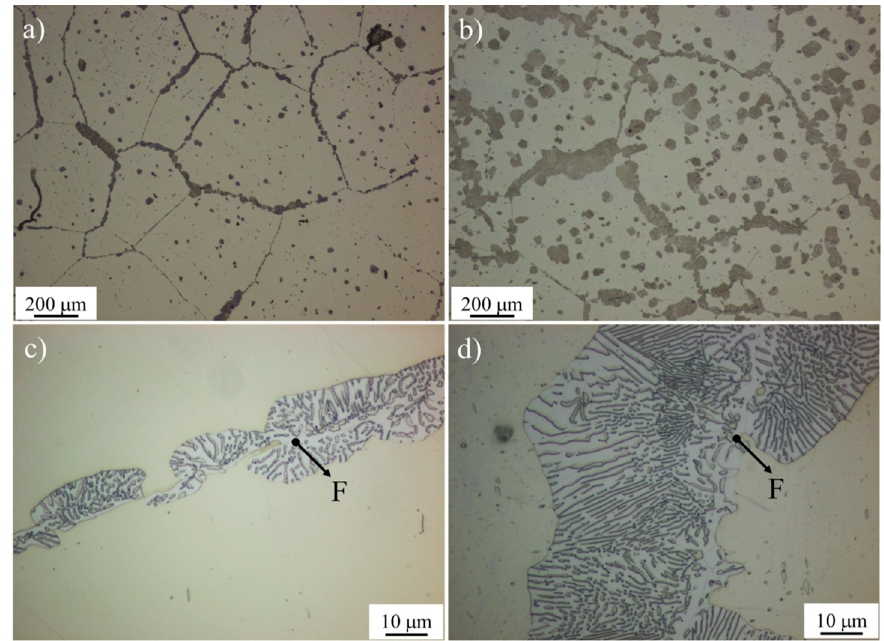
Figure 3. Optical micrographs showing the microstructural evolution during pearlite reaction for the Al-steel after heat treatment at 670 °C for ( a , c ) 3 days and ( b , d ) 13 days. In (c,d), it is evident that the volume fraction of proeutectoid ferrite (F) is negligible; moreover, over the reaction time, divergent pearlite can be highlighted. In (a,b), the dark areas correspond to pearlite, and the matrix is austenite. The lamellar structure in (c,d) corresponds to pearlite. Proeutectoid ferrite (F) is highlighted.